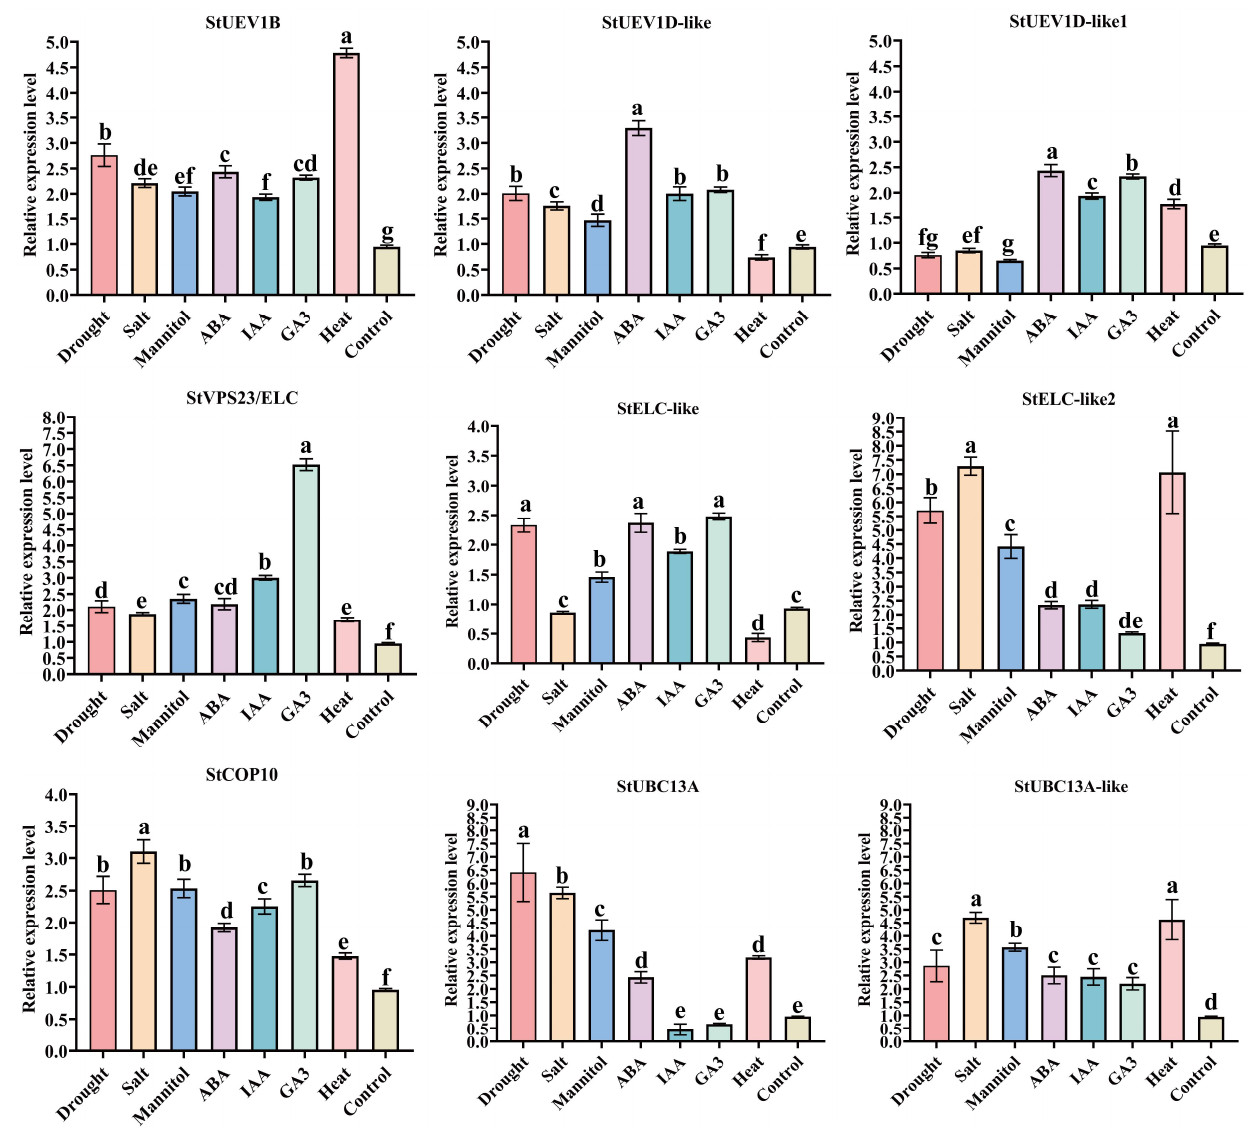
Figure 8. The qRT-PCR analysis of StUEVs and StUBC13 under different stress. Different small letters indicate the statistical differences of tissues when assessed using Duncan’s multiple range test ( p < 0.05, n = 3).